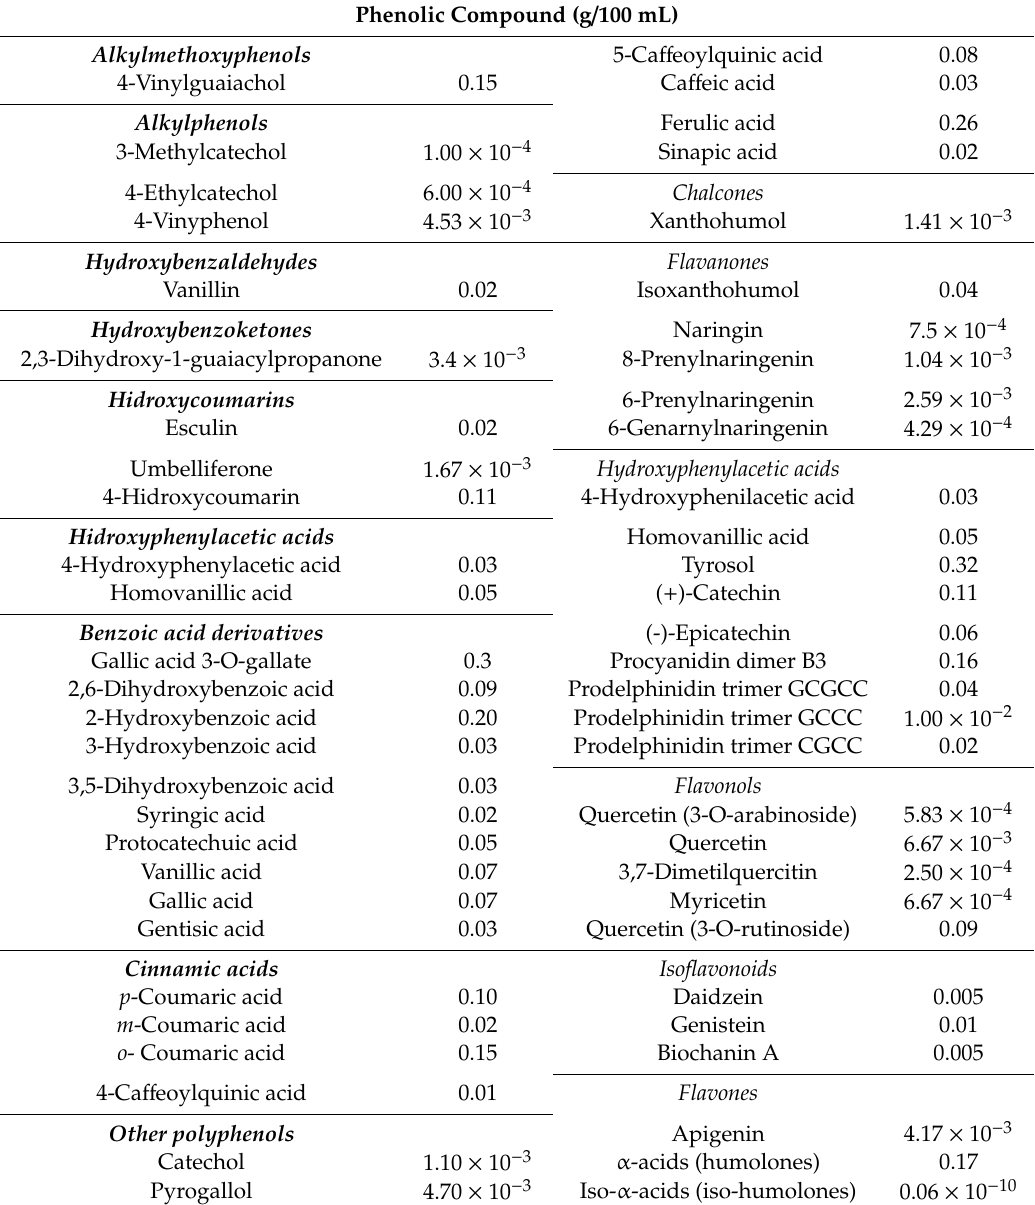
Table 3. Phenolic compounds in